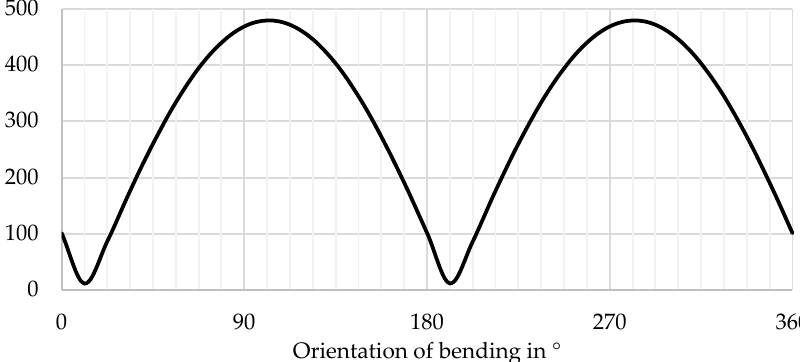
Figure 11. Local sensitivity of the sensor system σ B for small bending angles β in dependence of the bending orientation α .